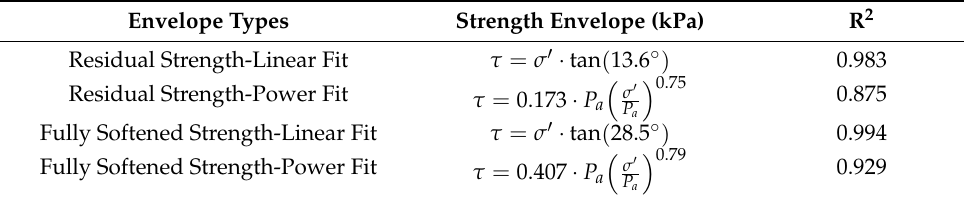
Table 2. Saturated shear strength envelopes.